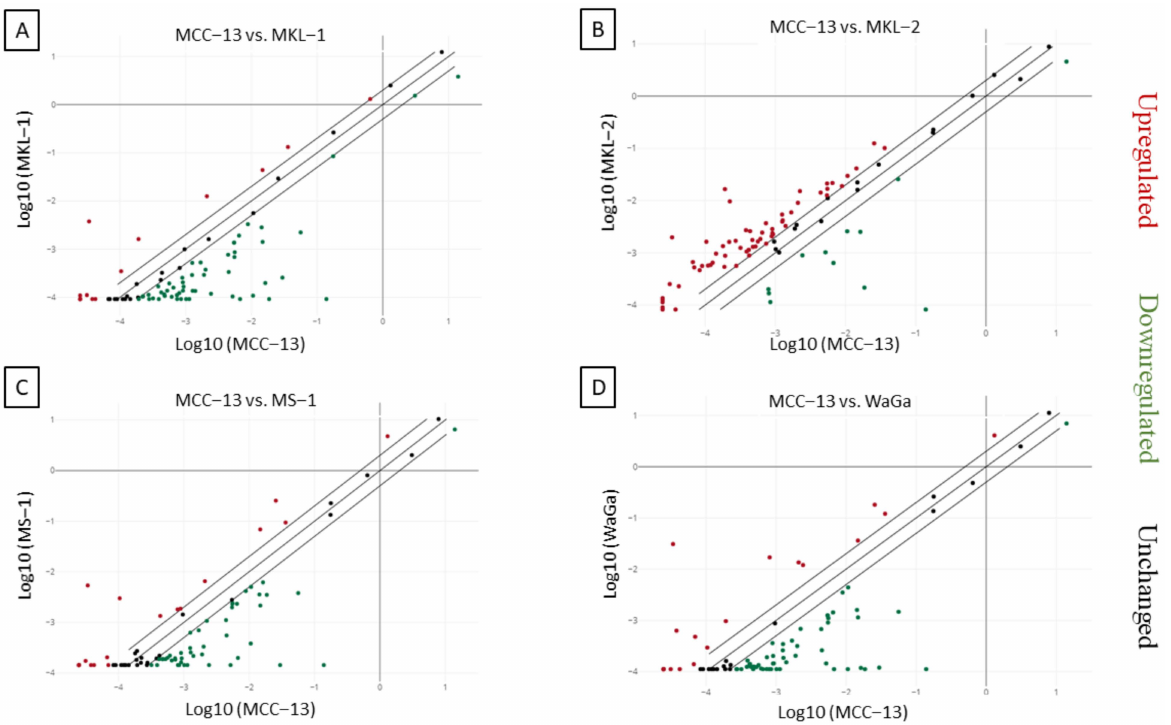
Figure 1. Relative expression comparison of 84 inflammatory cytokines and receptors genes between MCPyV-positive and negative Merkel cell carcinoma cell lines. The figure depicts a log transformation plot of the relative expression level differences for each gene (2 − ∆ Ct ) between ( A ) MCC-13 cells vs. MKL-1 cells, ( B ) MCC-13 cells vs. MKL-2 cells, ( C ) MCC-13 cells vs. MS-1 cells, and ( D ) MCC-13 cells vs. WaGa cells. The lines indicate a two-fold change in the gene expression